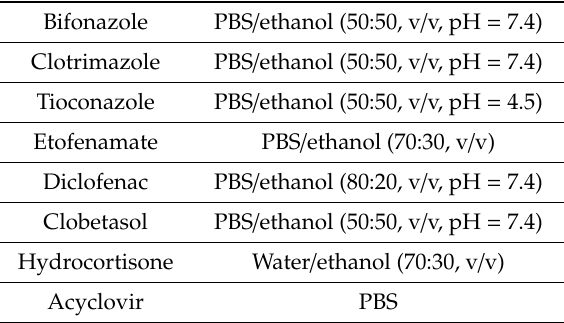
Table 2. Release media composition used for IVRT studies.